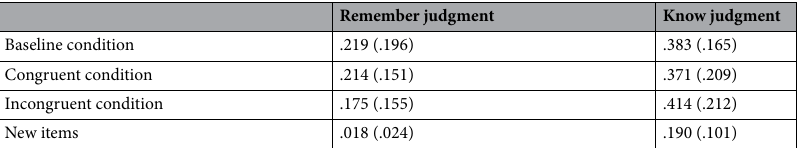
Table 1. Mean proportion of Remember and Know judgments for old items in each condition and for new items during the recognition task in Experiment 1. SD in parentheses.